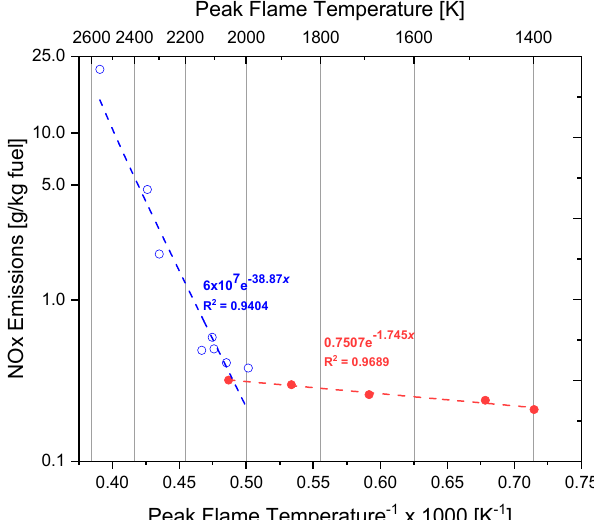
Figure 11. NO X emissions vs. peak flame temperatures for all operating parameters at low load condition (1500 rev.min − 1 , 8 mg/cycle fuelling